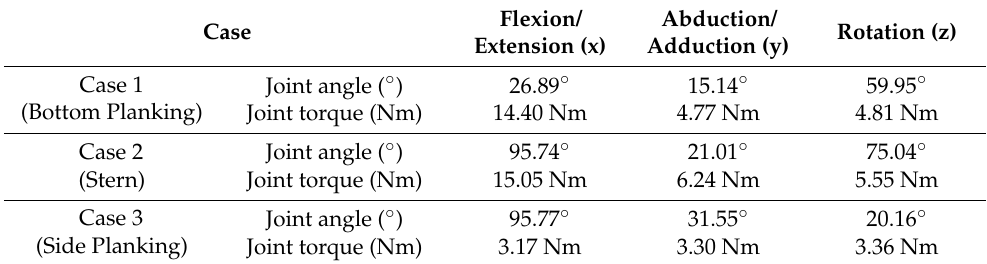
Table 1. Joint angle and joint torque results of various working motions at motion capture.